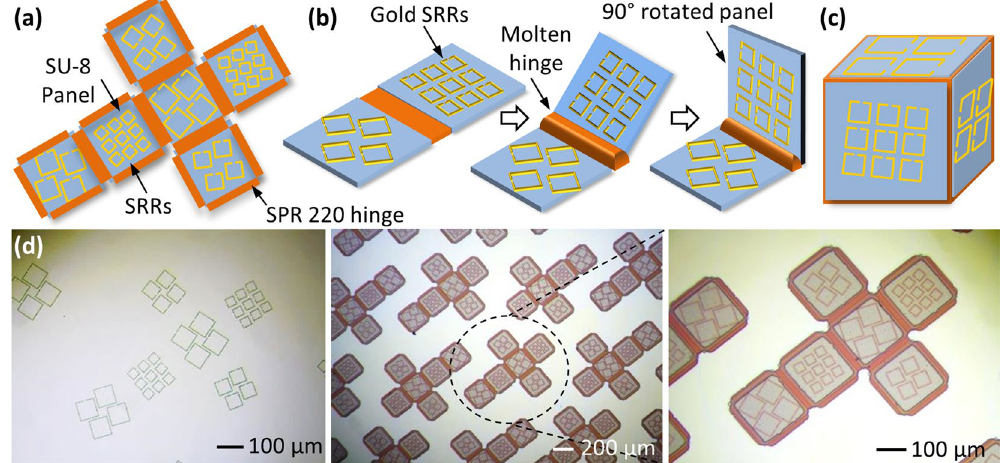
Figure 4. Fabrication process of the Triaxial inclinometer. ( a ) Illustration of the two dimensional planar configuration before the self-folding is initiated, showing the SU-8 panels, the Au SRRs and the SPR 220 hinges ( b ) Illustration of the self-folding process, demonstrating the melting of the hinge causing it to flow and generating a surface tension force that slowly lifts up and folds the panel to a 90° angle ( c ) Illustration of the folded 3D cubic structure through surface tension driven self-assembly, where the SU-8 panels form the faces of the cube once the hinges re-solidify ( d ) Optical images of the fabrication process for the cubic SRR inclinometer, starting with the patterning of Au SRRs, followed by the deposition of SU-8 panels and the SPR 220